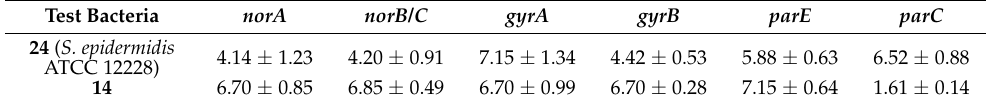
Figure 4. Comparison of gene expression values of the test bacteria of the control group, which developed resistance to ciprofloxacin following subculturing only in LB broth without aluminum chlorohydrate for 30 days, and the test bacteria of the control group, which were taken as starter on the first day. ns : not significant. One-way ANOVA was used to compare the means of the groups. Tukey’s post hoc test was performed to make pairwise comparisons. Bars represent standard deviations. Table 3. Relative fold change in resistance gene expression levels in the control group test bacteria, which developed resistance to ciprofloxacin following subculturing only in LB broth without alu- minum chlorohydrate for 30 days, and the control group test bacteria taken on the first day as the